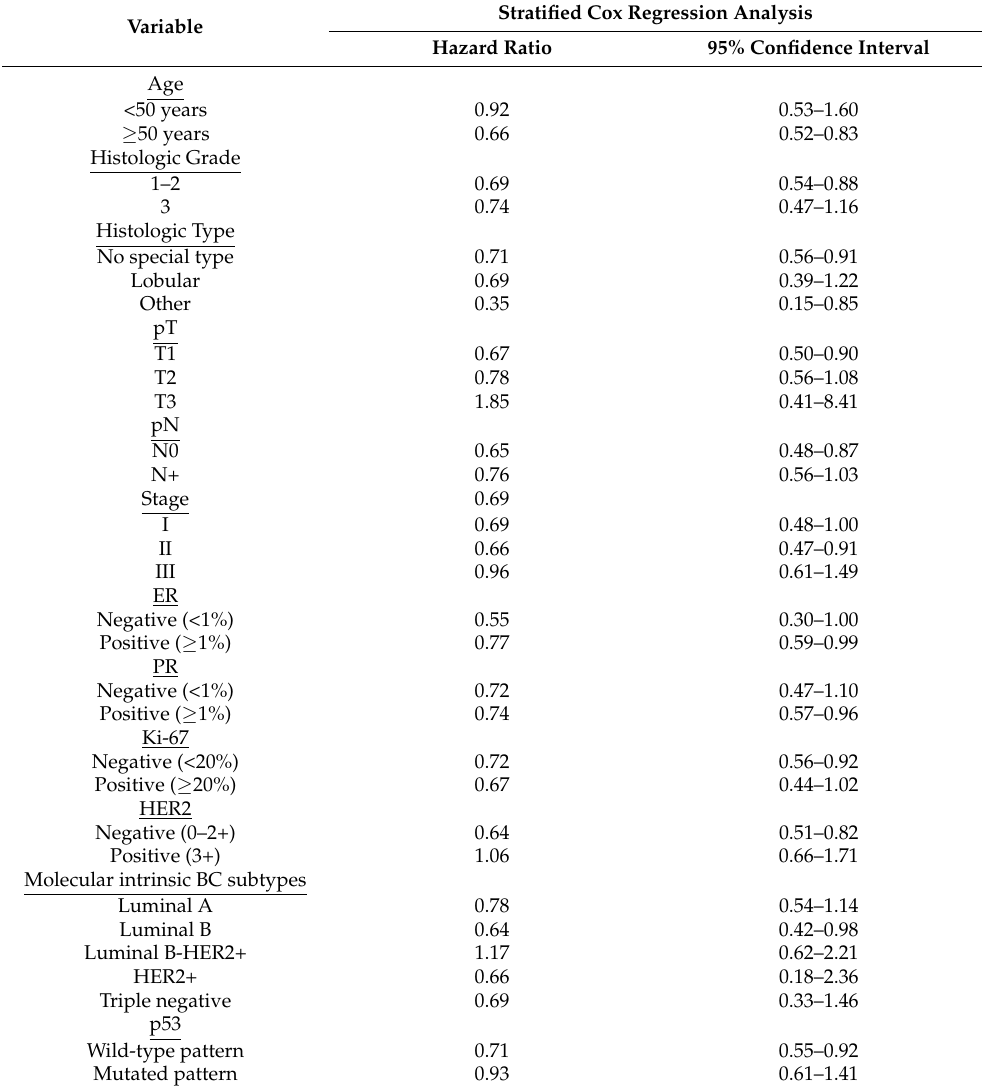
Table 2. The prognostic value of GATA3 positivity stratified by clinico-pathological features and bio- logical prognostic factors. Age-adjusted HRs are estimated through proportional hazard Cox